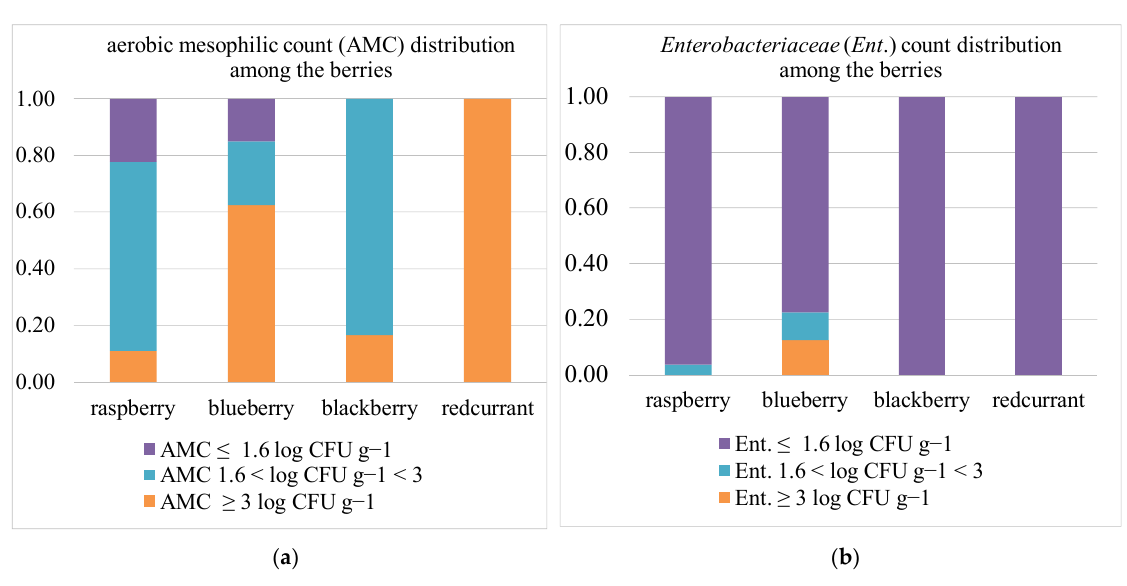
Table 3. Log CFU descriptive statistics for aerobic mesophilic count, Escherichia coli , and Enterobacteriaceae . Bacteria counts were converted to log CFU and were expressed as mean ± standard deviation (SD). The prevalence of the parameters was calculated, as well as 95% confidence intervals (CI 95%) by binomial exact methods.